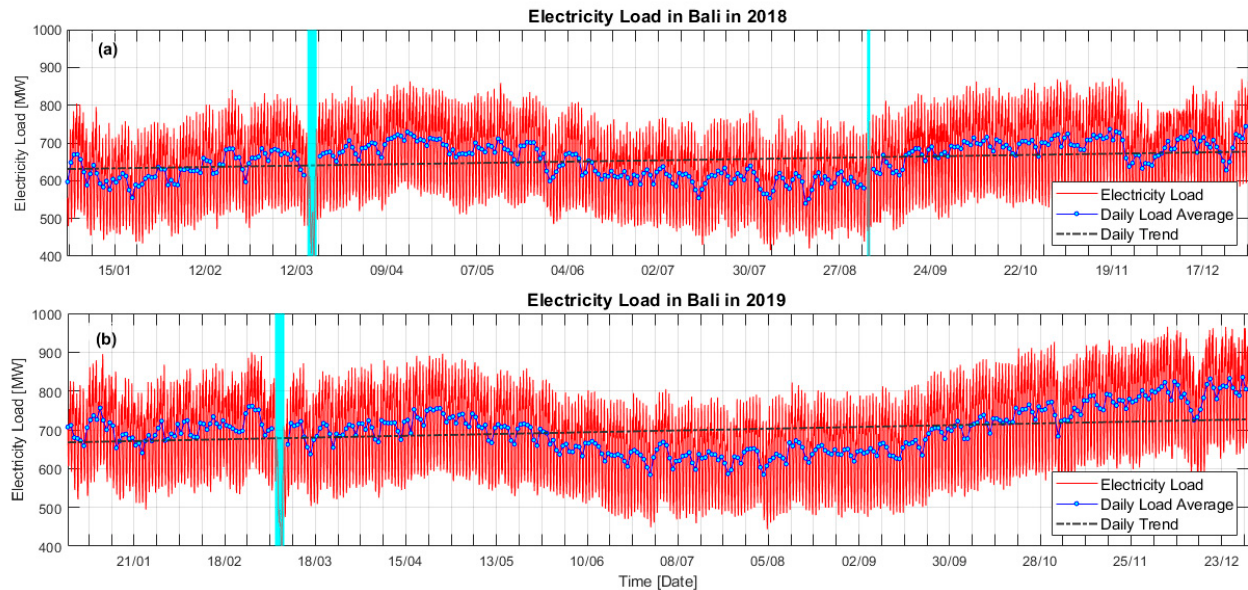
Figure 1. Electricity load data in Bali Island during 2018 ( a ) and 2019 ( b ). Hourly, daily, and daily trend electricity load are denoted by red line, blue line with circle, and black dot-dashed line, respectively.